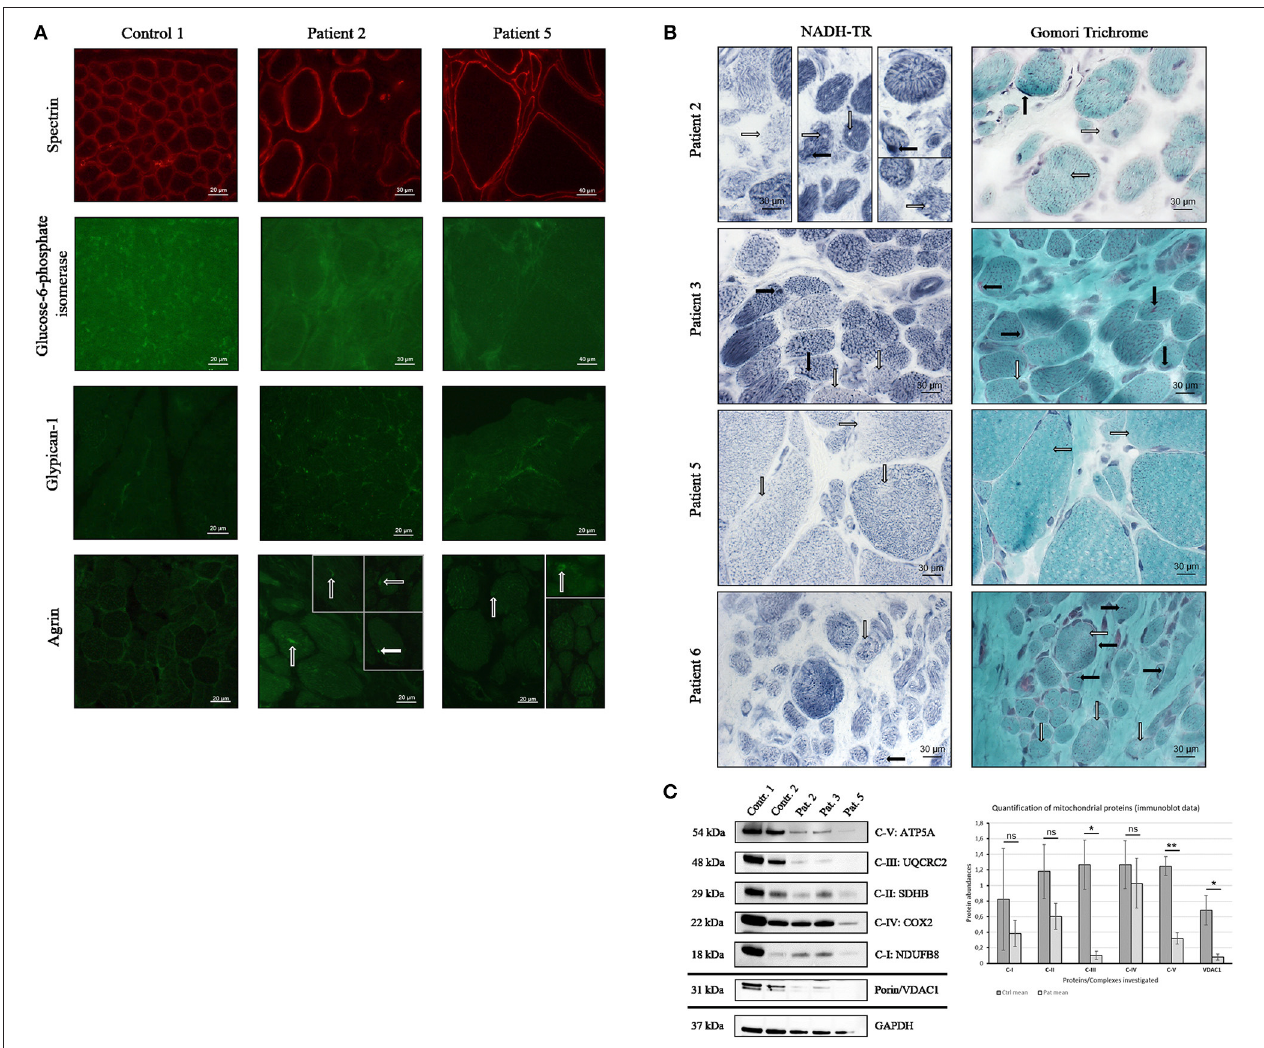
FIGURE 4 | Confirmation study of proteomic findings in independent MDC1A-patient derived muscle biopsies. (A) Immunofluorescence studies of spectrin have been carried out to visualize sarcolemma in muscle cryostat sections of control and patient-derived muscles and to show similar abundance and localization of the protein. Further immunofluorescence studies of glucose-6-phosphate isomerase reveal a focal dot-like sarcoplasmic staining/ enrichment in muscle biopsy specimen derived of controls (one representative control is shown here) but show a decrease in the biopsies of two representative MDC1A-patients. Immunofluorescence studies of glypican-1 showed focal enrichment at the sarcolemma of control muscle (one representative control is shown). However, in the LAMA2-diseased muscle fibers, small dots sarcoplasmic, and (sub-)sarcolemmal dots immunoreactive for glypican-1 were detected. Immunofluorescence studies of agrin revealed of a sarcoplasmic enrichment/ aggregation in MDC1A-patient derived muscle fibers (white arrows) compared to control muscle fibers. (B) Histological NADH-TR staining revealed “sarcoplasmic gaps” (white arrows in patient 2; second and third column) and reduced enzyme activity (white arrows in patient 2, 3, 5, and 6) as well as focal enrichment in some myofibers (black arrows in patient 2, 3, and 6). Modified Gomori Trichrome staining revealed sarcoplasmic areas with minor staining (white arrows in patient 2, 3, 5, and 6) as well as areas of sarcoplasmic and subsarcolemmal enrichment (black arrows in patient 2,3, and 5). (C) Immunoblot analysis of proteins representative for the respiratory chain complexes I-V and of VDAC1 (porin) revealed a statistically significant decrease of complexes III and V as well as of VDAC1 in MDC1A-patient derived protein muscle extracts compared to controls (diagram). GAPDH has been used as loading control and proteins have been quantified against GAPDH (ns, not significant; *statistically significant, **statistically very